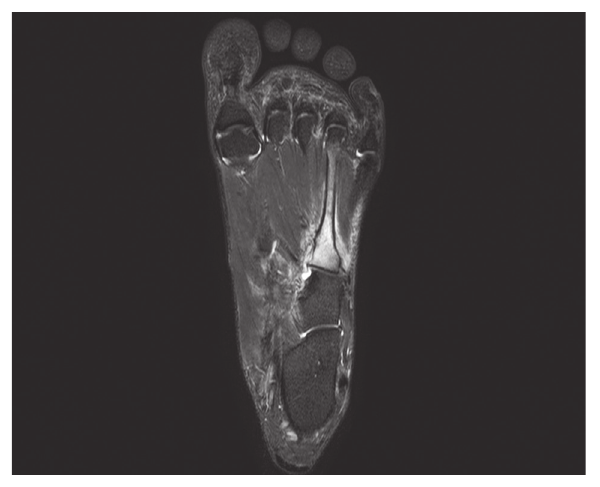
FIGURE 7: Long axis STIR MR image of the foot demonstrating oedema in the 4th metatarsal owing to a stress fracture.